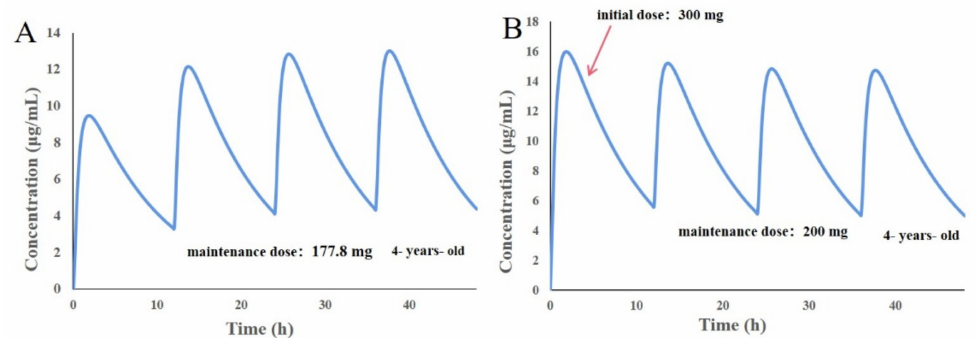
Figure 8. Predicted results of the oral PBPK model in 4-year-old Chinese children. ( A ) 177.8 mg, q 12 h; ( B ) 300 mg + 200 mg, q 12